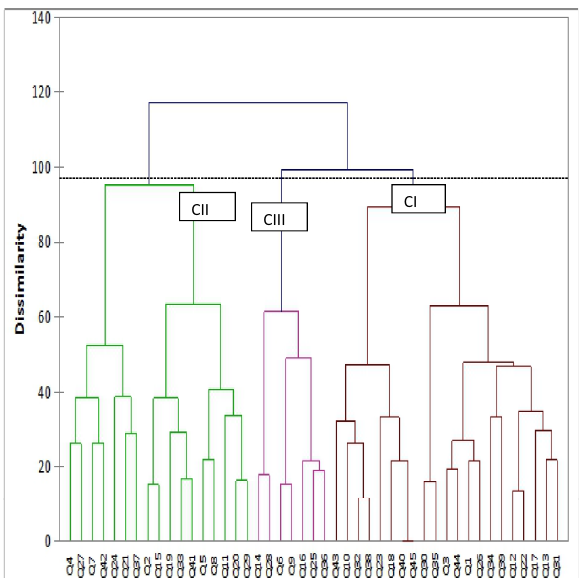
Fig. 3 Dendrogram that represent plant Community types of Hereje forest. Where CI = community I, CII = community II, CIII = community III. Community type I = Plots 31,13,17,22,12,39, 34,26,1,44,3,35.30,45,40,18,23,38,32,10 and 43. Community type II = Plots 29,20,11,8,5,41,33,19,15,2,37,21,24,42,7,27 and 4. Commu- nity type three = Plots 14, 28, 6, 9, 16, 25 and